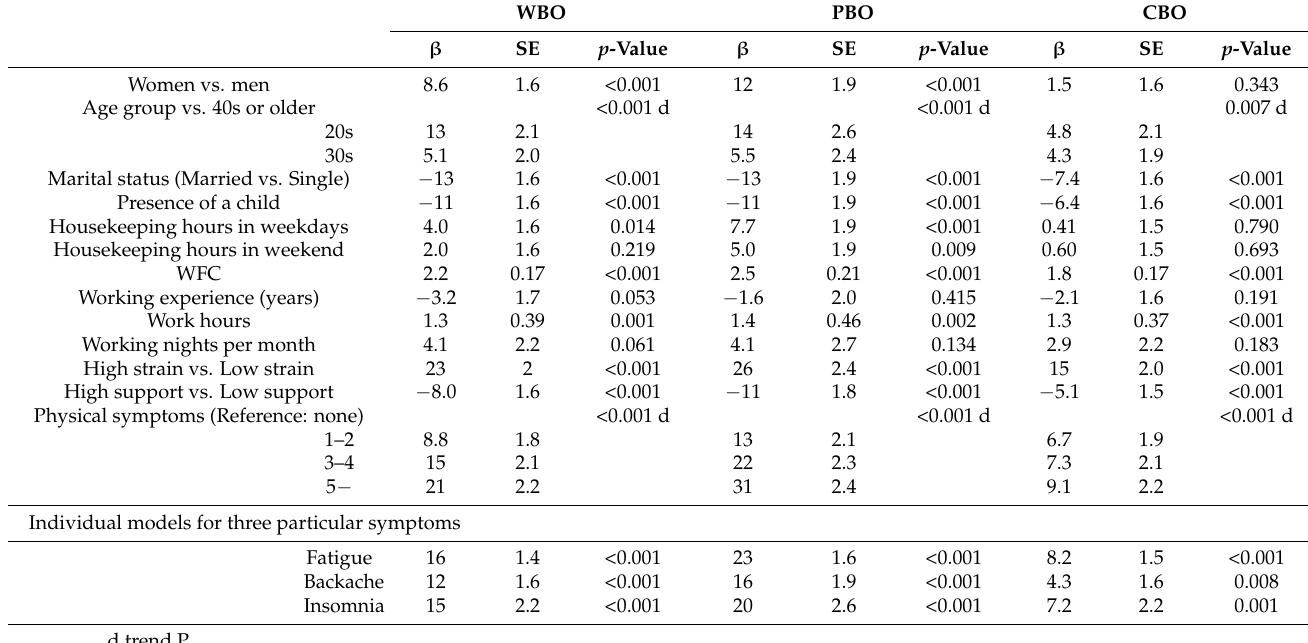
Table 3. Univariable models of an effect of covariates according to burnout subscale among